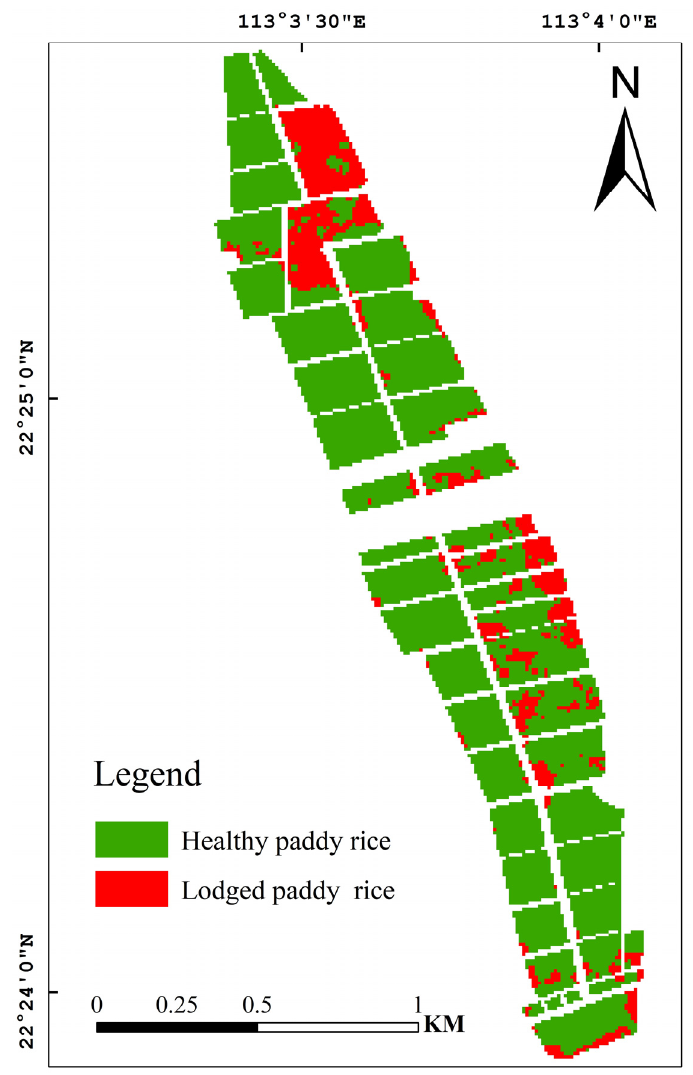
Figure 9. Map of lodged paddy rice extraction